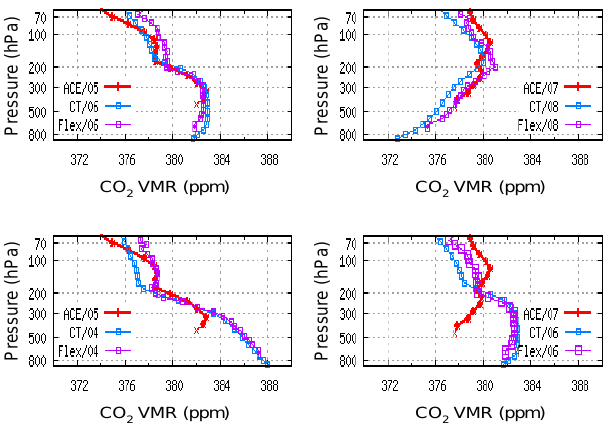
Fig. 11. Flexpart (purple), CT (blue), and ACE (red) CO 2 profiles for the 50 ◦ N–60 ◦ N latitude band in 2006. ACE profiles in May (left) and July (right) are compared to Flexpart and CT profiles of one month before (top), and of one month after (bottom). ACE thin red line indicates that less than 10 occultations were available.